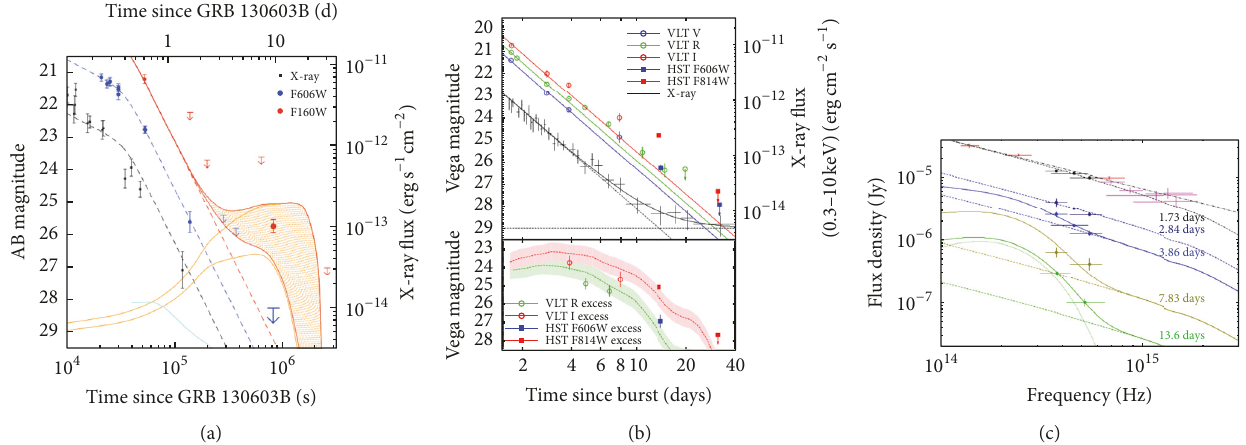
Figure 17: Observations of KNe associated with SGRBs: (a) GRB 130603B, from [395]. The decomposed optical and NIR LCs show an excess of flux in the NIR ( 𝐹160𝑊 ) filter, which is consistent with theoretical predictions of light coming from a KN. (b) GRB 060614, from [396]. Multiband LCs show an excess in the optical LCs ( 𝑅 and 𝐼 ), which once the AG light is removed, the resultant KN LCs match those from hydrodynamic simulations of a BH-NS merger (ejecta velocity of ∼ 0.2 𝑐 and an ejecta mass of 0.1M ⊙ [397]). (c) SEDs of the multiband observations of GRB 060614, also from [396]. The early SEDs are well described by a power law spectrum, which implies synchrotron radiation. However, at later epochs the SEDs are better described by thermal, black body spectra, with peak temperatures of ∼ 2700 K, which are in good agreement with theoretical expectations